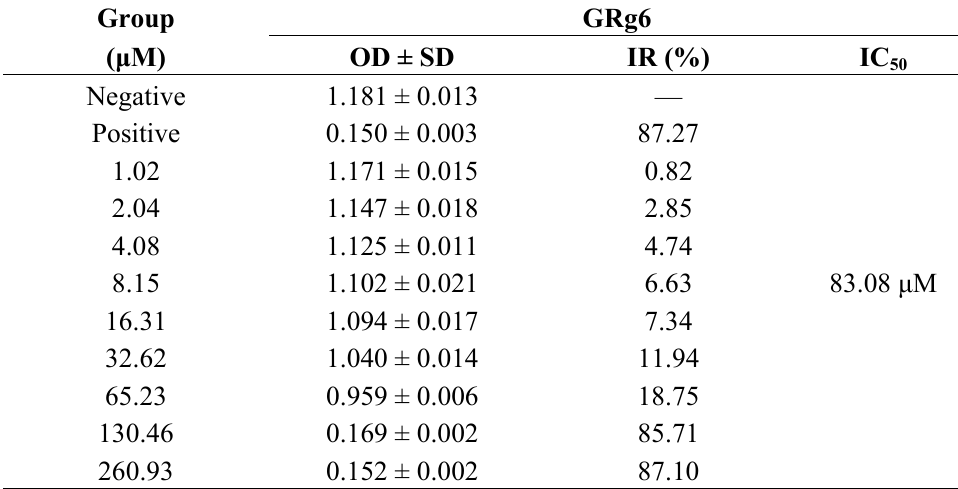
Table 1. Cell proliferation detecting using CCK-8 method.